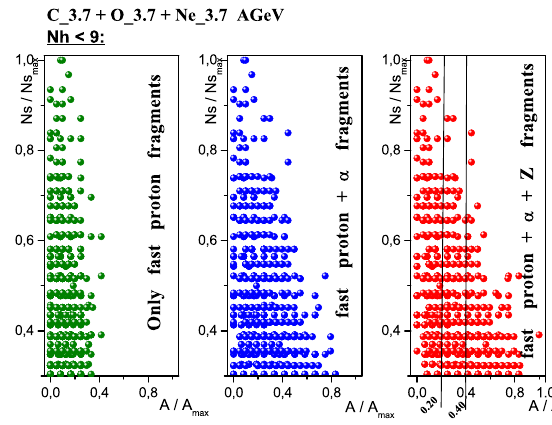
Figure 4. Multiplicity-fragmentation correlations for (C, O, Ne) + (C / N / O) interactions